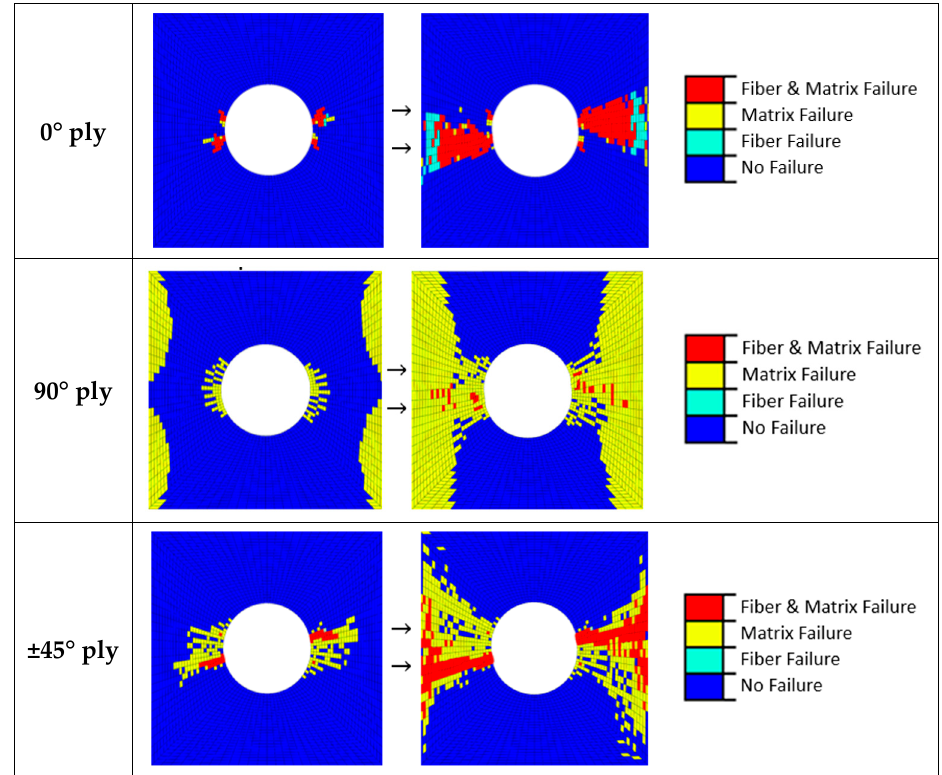
Figure 15. Failure patterns for different oriented plies of the CFRP laminate.